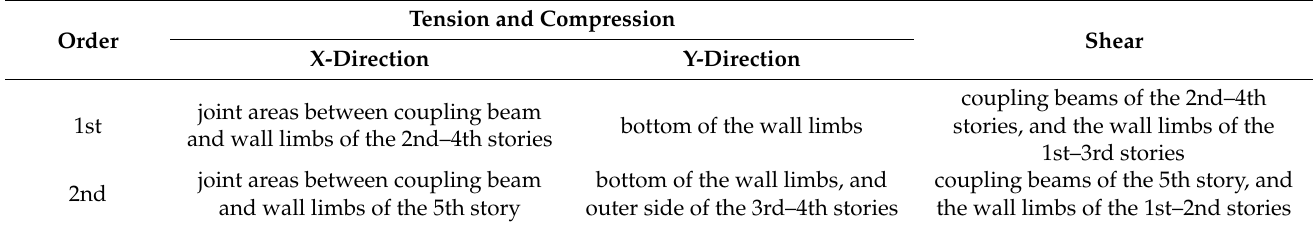
Table 4. Relatively weak areas of shear wall B under the first- and second-order vibration modes.